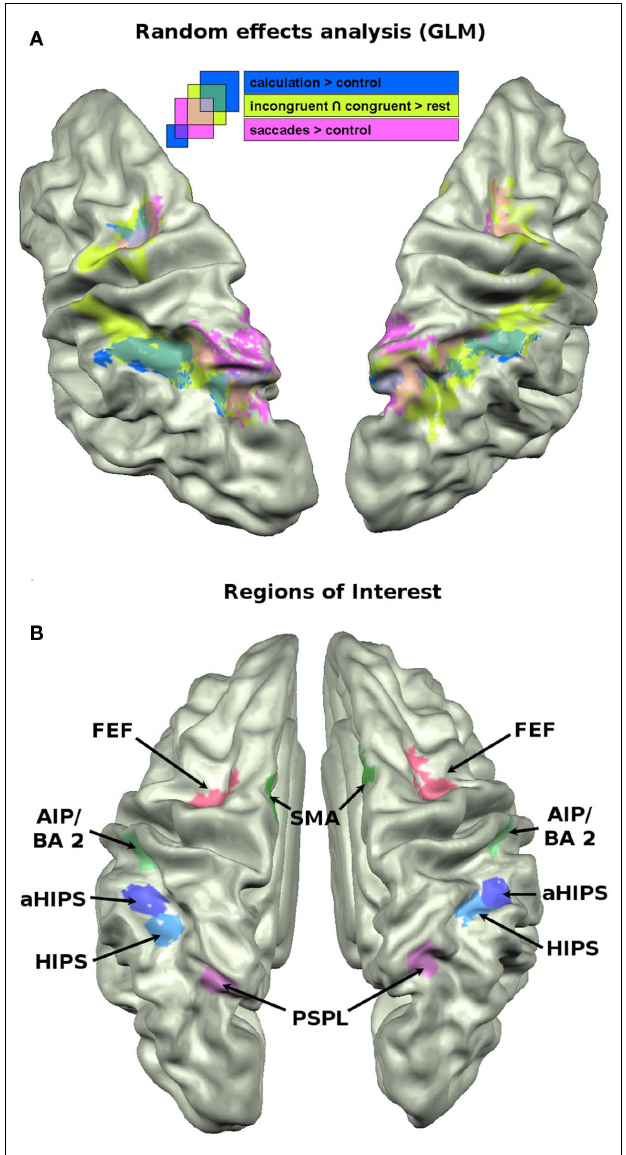
FIGURE 2 | (A) Brain activation data of the GLM analysis ( p = 0.005) projected on the cortex based aligned average anatomy of the sample. Mapped contrasts: conjunction of incongruent and congruent vs. baseline (green); subtraction vs. control (blue); saccades vs. control (pink). (B) The 12 ROIs that were used for across voxel correlations, MVPA, and cluster